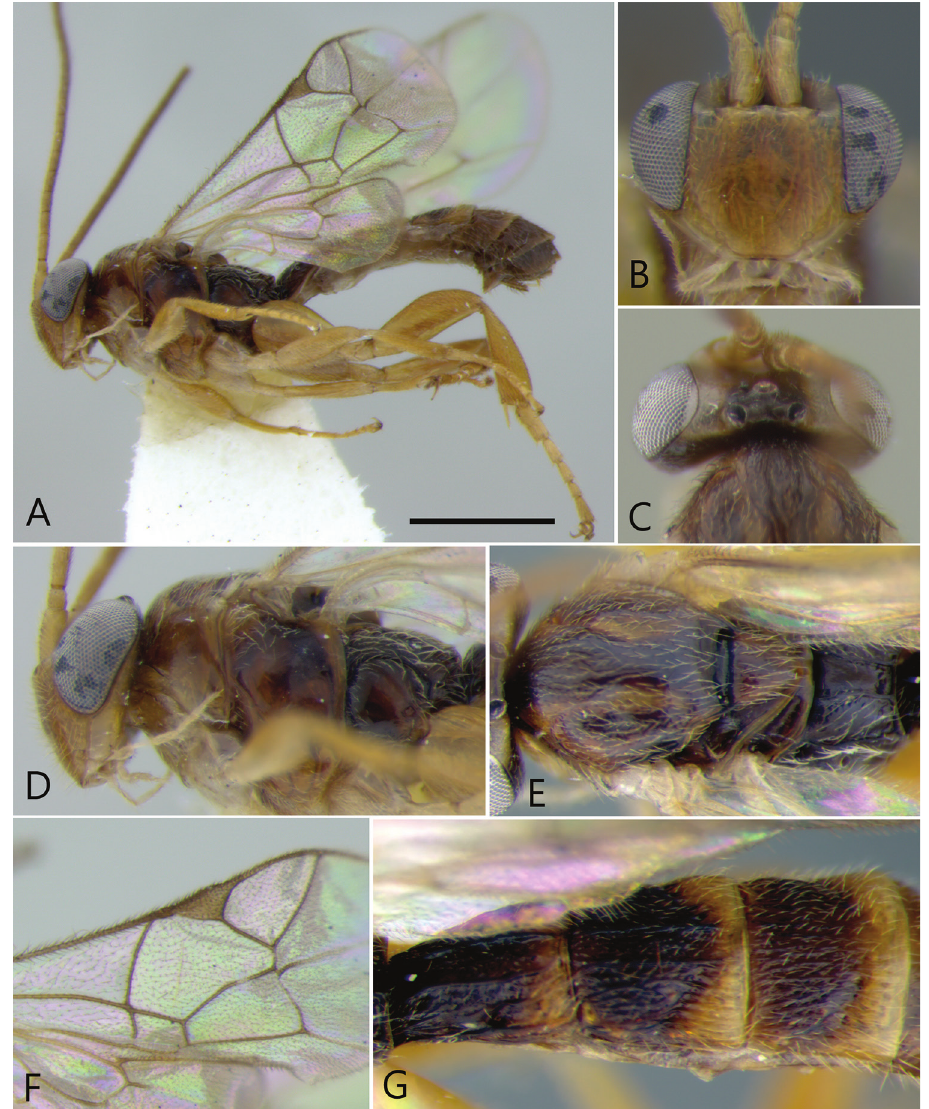
Figure 5. Orthocentrus flavescens sp. nov. Holotype. A Habitus in lateral view B head in frontal view C head in dorsal view D head and mesosoma in lateral view E mesosoma in dorsal view F areolet G first to third tergites in dorsal